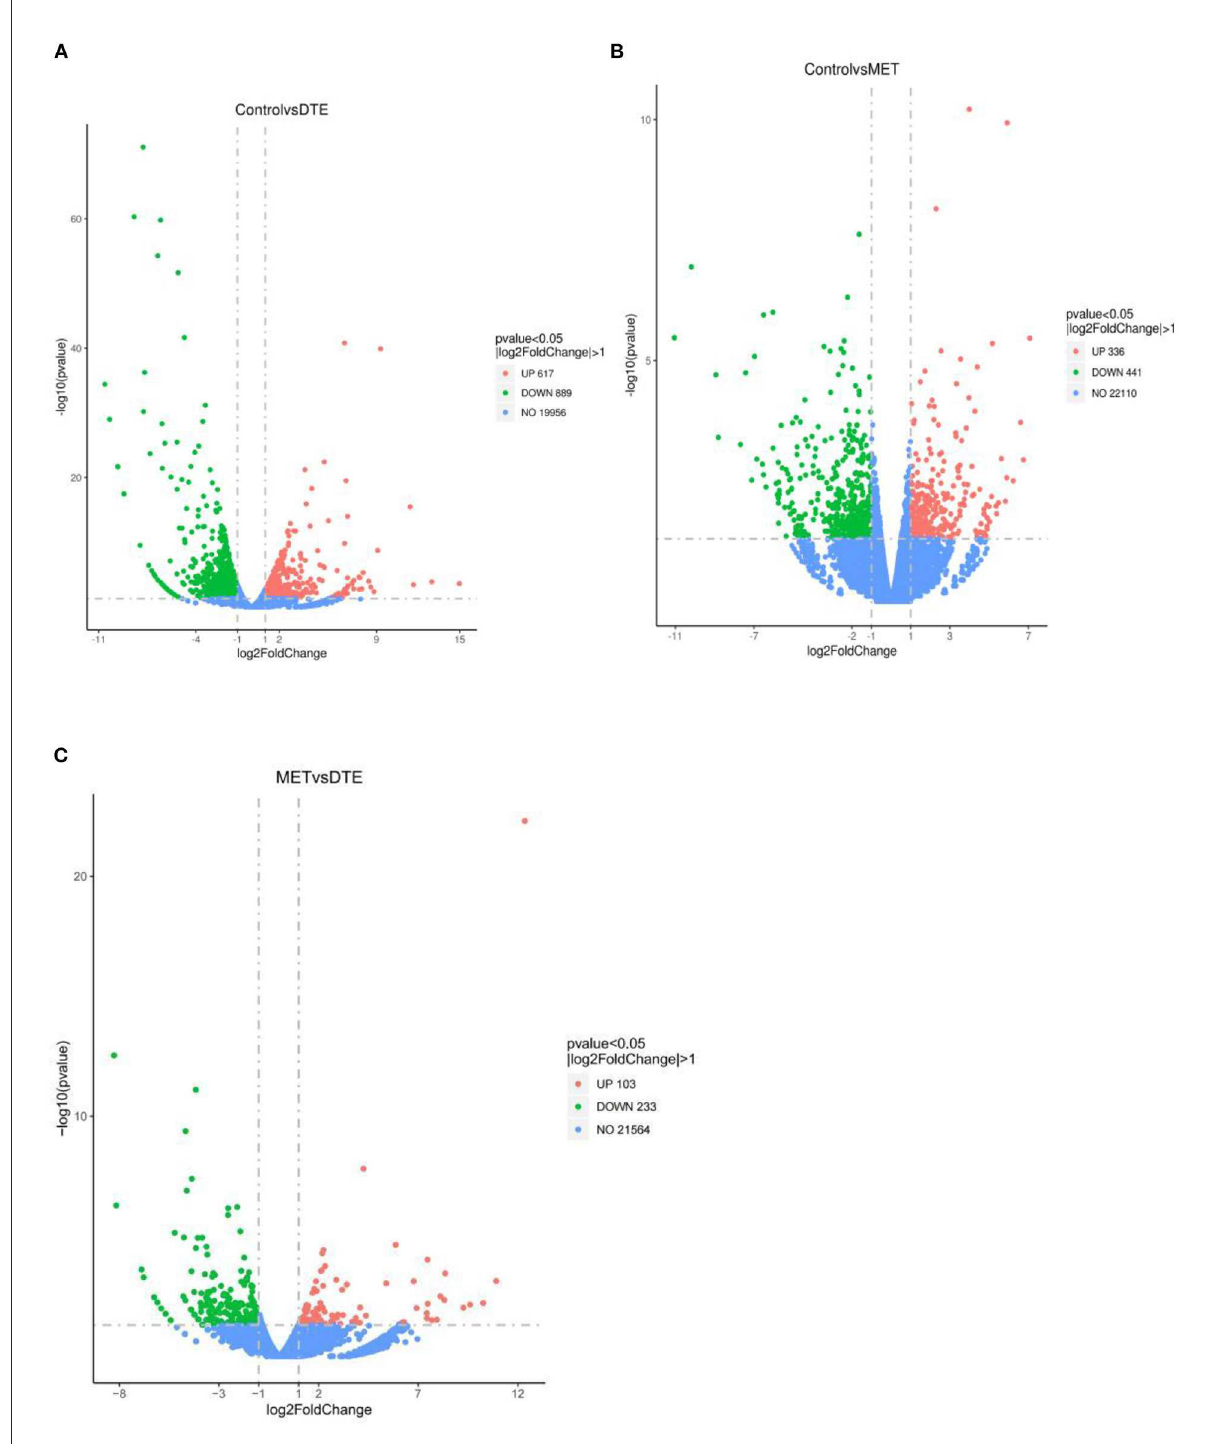
FIGURE4 Volcanic map of difference gene expression between groups. (A) Control vs. DTE; (B) Control vs. MET; (C) MET vs. DTE.